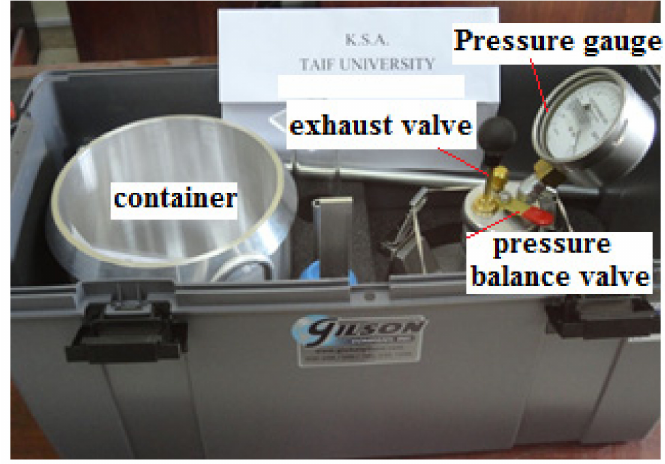
Figure 4. Air content testing